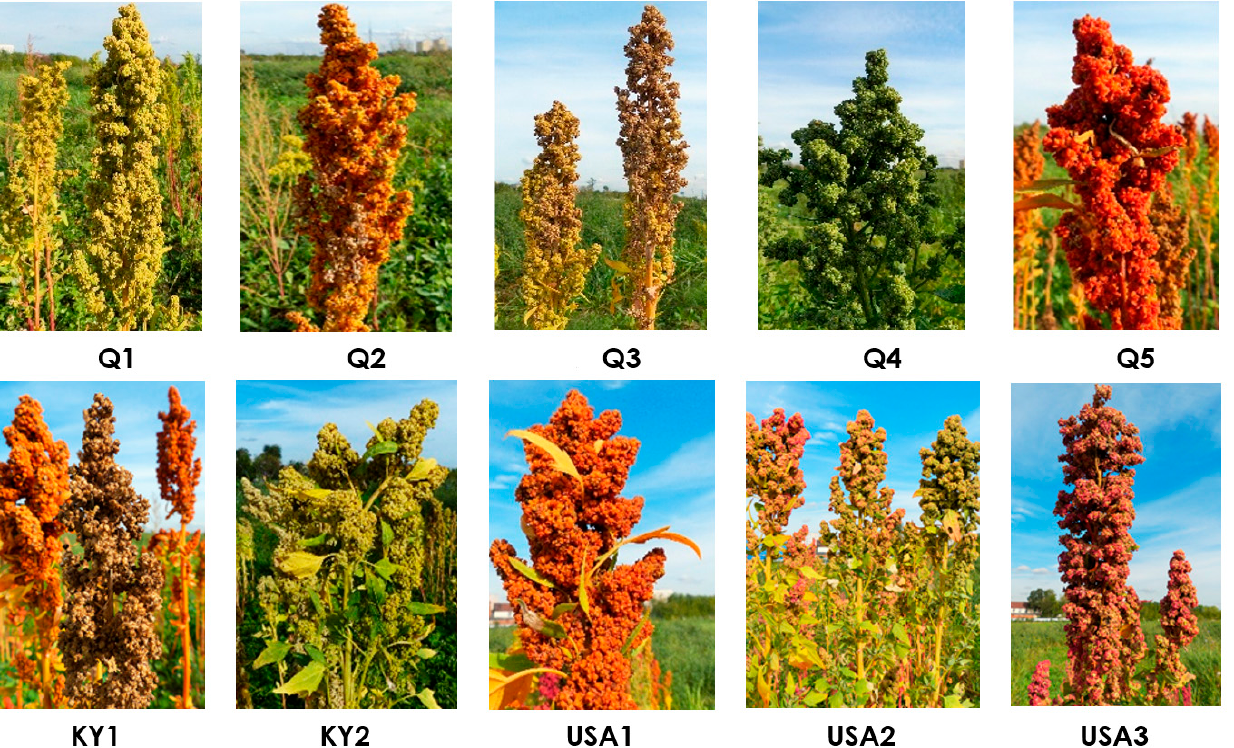
Figure 3. Inflorescences (panicles) of the studied quinoa genotypes during the grain ripening stage.